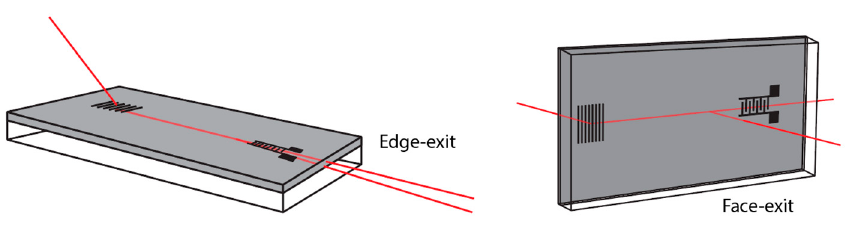
Figure 1. An example of an edge-exit vs. face-exit device.